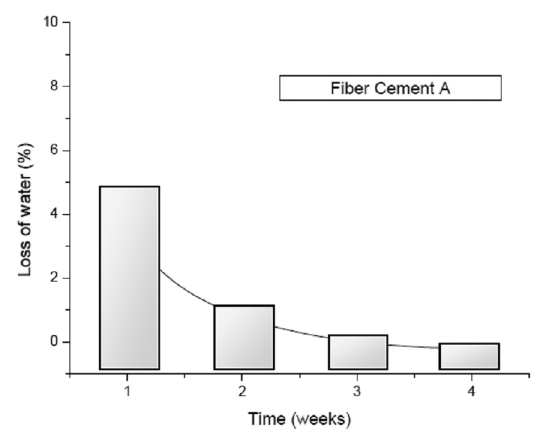
Figure 5. Loss of water evolution up to 28 days – fiber cement